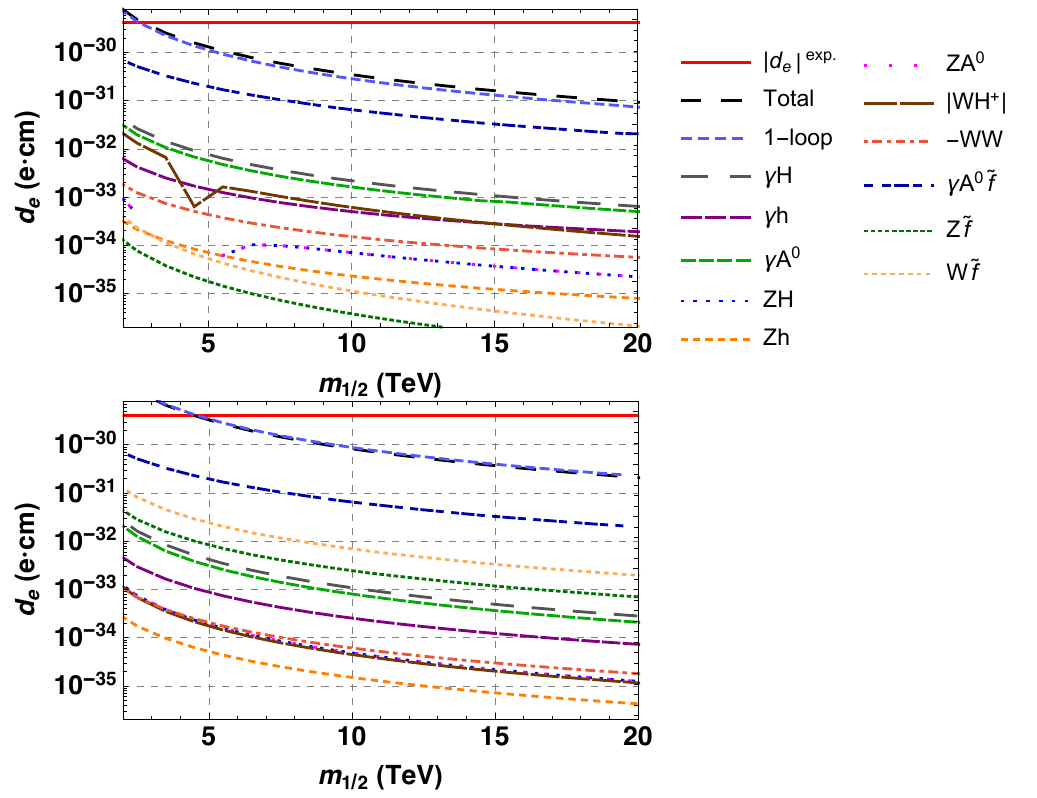
Figure 8 . Comparison of the contributions from Barr-Zee diagrams as a function of m 1 m 0 = 1 . 1 m 1 , tan β = 10 . Top plot: θ µ /π = 0 . 00015 and θ A = 0 , lower plot: θ µ = 0 , / 2 × θ A /π = 0 . 025 and A 0 = 3 m 0